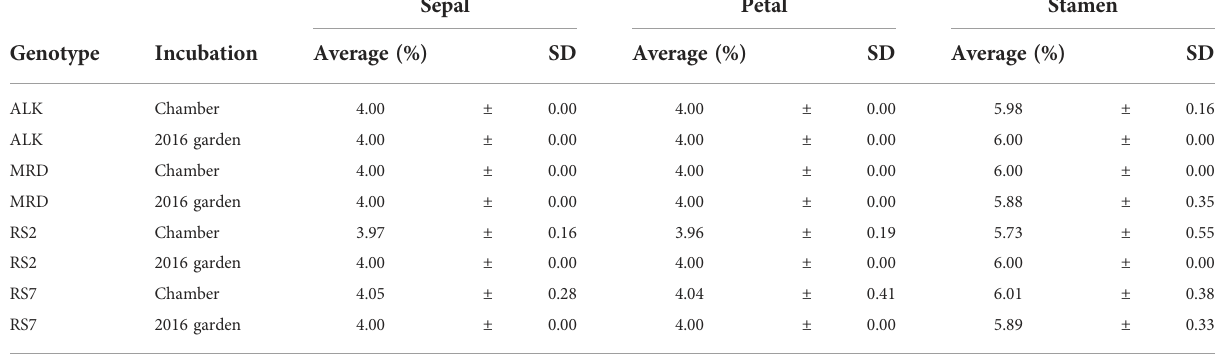
TABLE 3 The number of fl oral